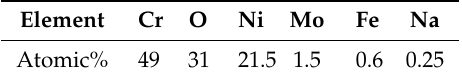
Table 8. The atomic percentage of Inconel 625 sample surface after 100 h testing. Element